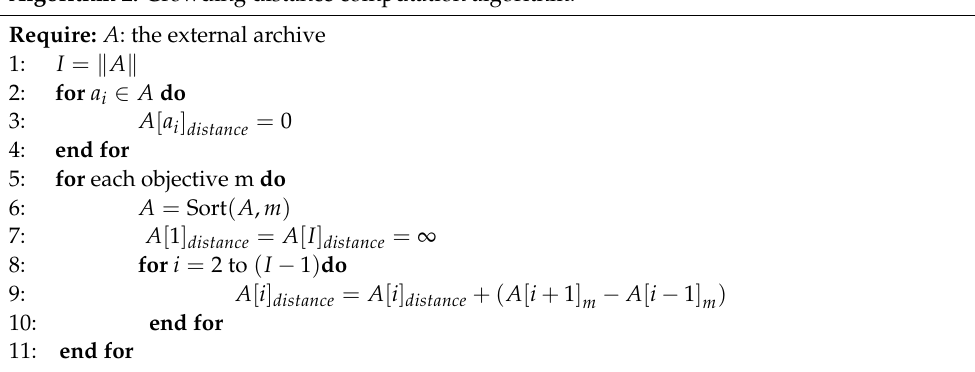
Algorithm 2. Crowding distance computation